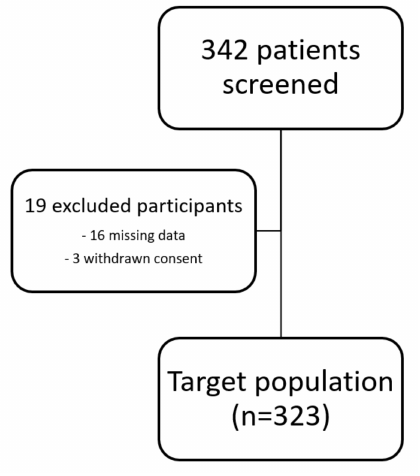
Figure 1. Flow chart of study